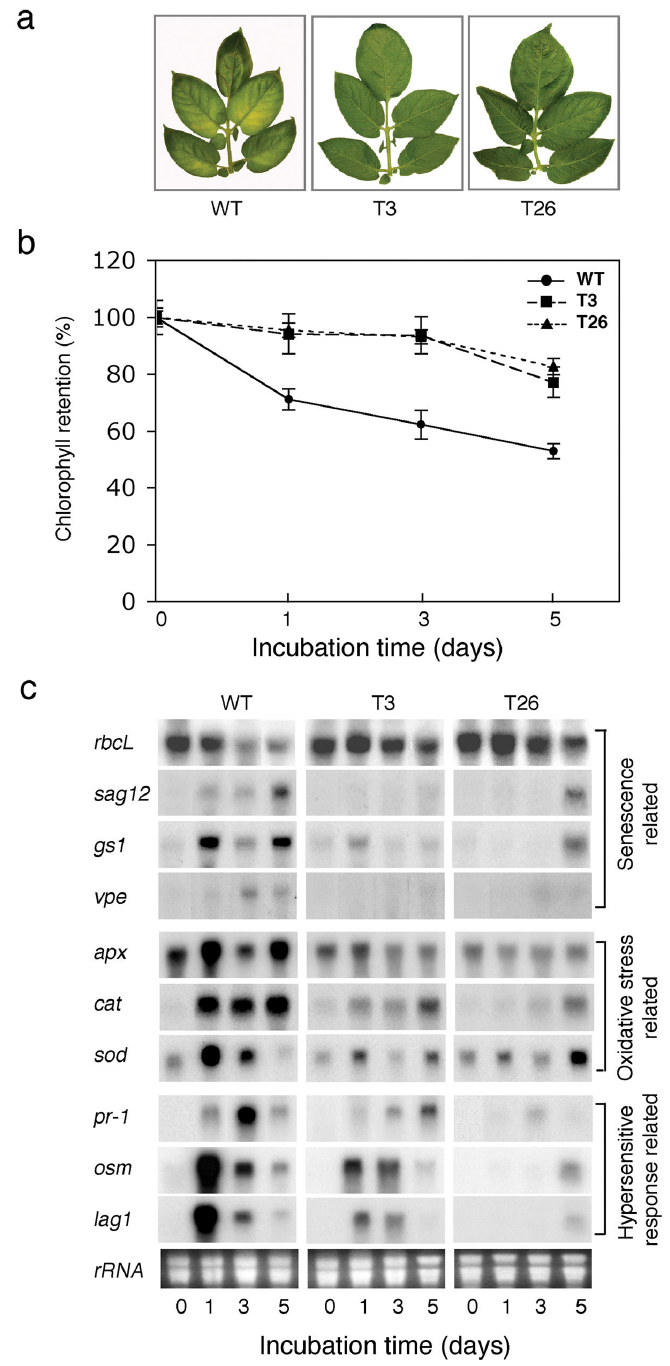
Figure 2. msrA3 -transgenic plants display delay in dark-induced senescence. (a) Detached compound leaves (5 th to 6 th from top) of five week-old plants were incubated in the dark on moist filter paper in Petri dishes at room temperature and were photographed after 5 days incubation in dark. The Petri dishes were wrapped in aluminum foil to create dark conditions. The experiment was repeated at least three times and the representative results are shown here. (b) Percent retention of chlorophyll in wild-type and transgenic plants. The leaves were sampled for analysis at indicated times after incubation in darkness. Bars represent means + SE (n=3). (c) Expression profile of genes involved in HR and associated senescence in wild-type and msrA3 - transgenic plant leaves kept in the dark (as stated in section [a]) at room temperature for the indicated times. Each lane was loaded with 20 μg of total RNA. Ethidium bromide stained rRNA served as loading control. doi: 10.1371/journal.pone.0077505.g002 PLOS ONE |